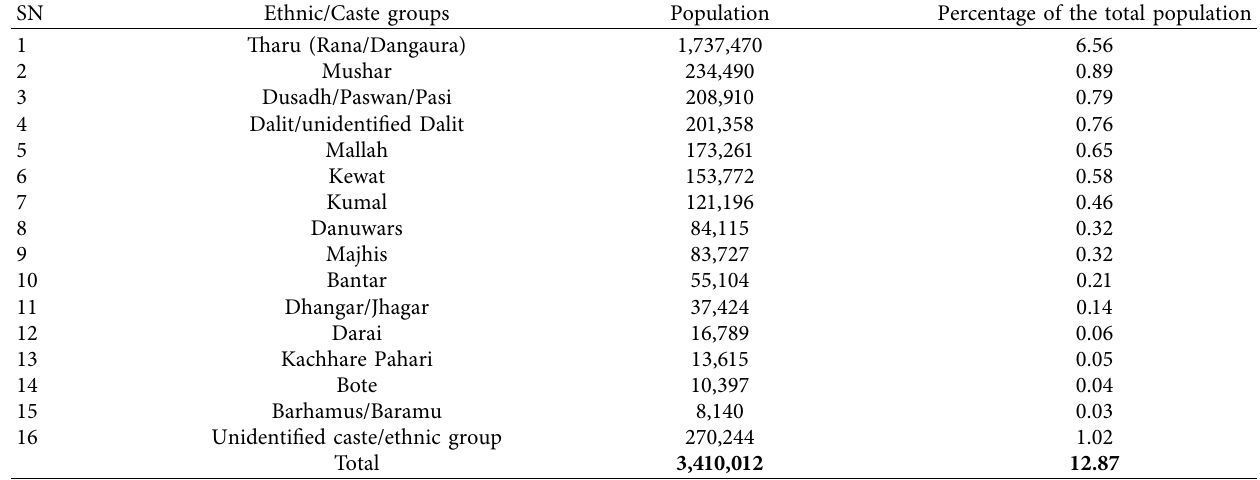
Table 11: Ethnic groups involved in traditional fish farming with their populations and population percentage in Nepal. SN